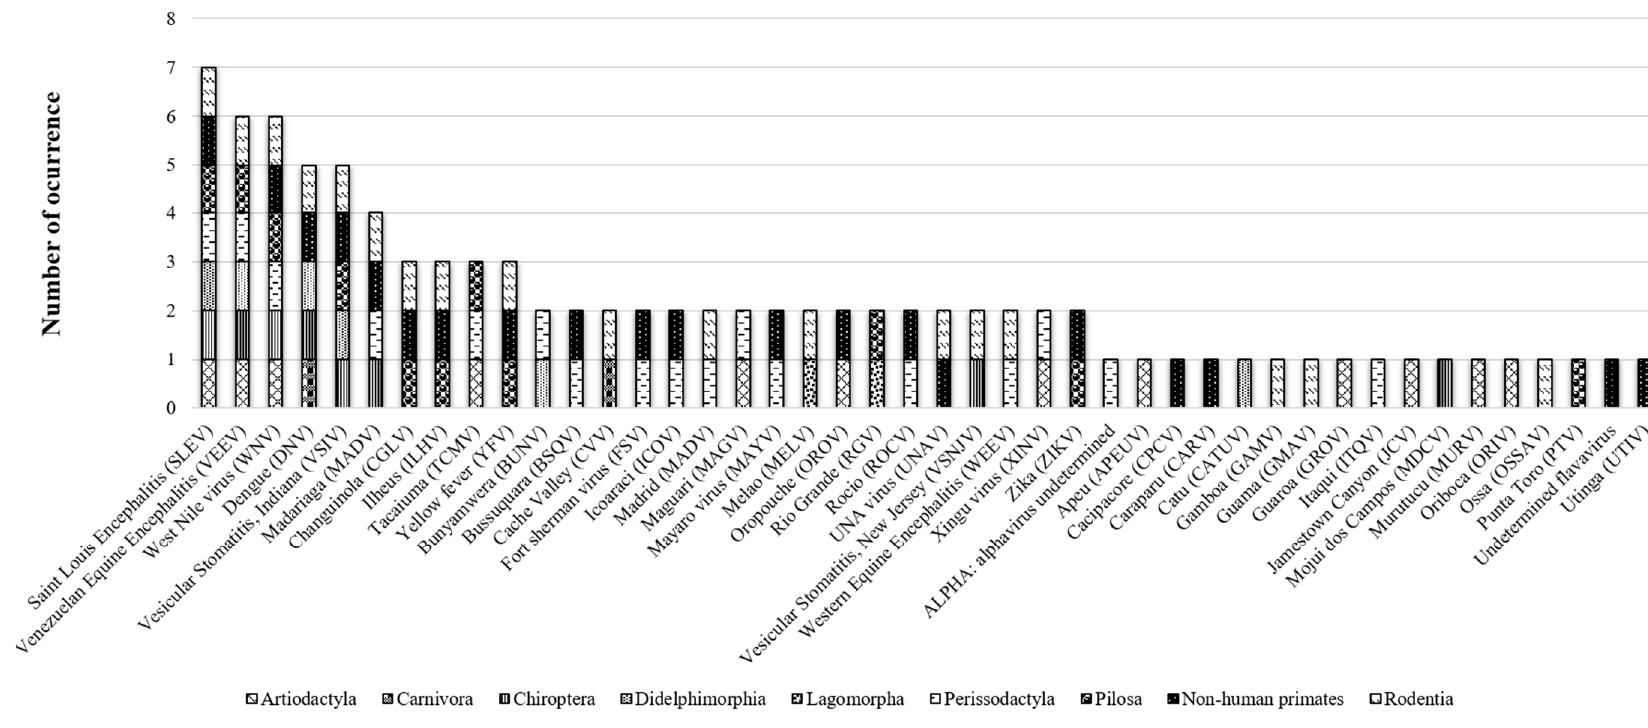
Figure 5. Arbovirus records by mammalian order in the Neotropics.